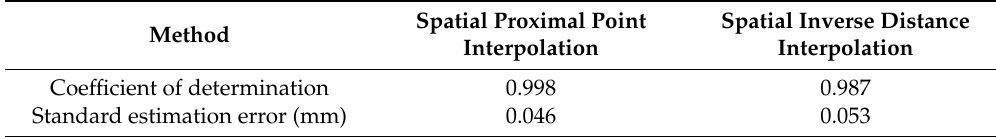
Figure 11. Estimation of deformation missing data process lines. Table 5. Accuracy of the two estimation methods.